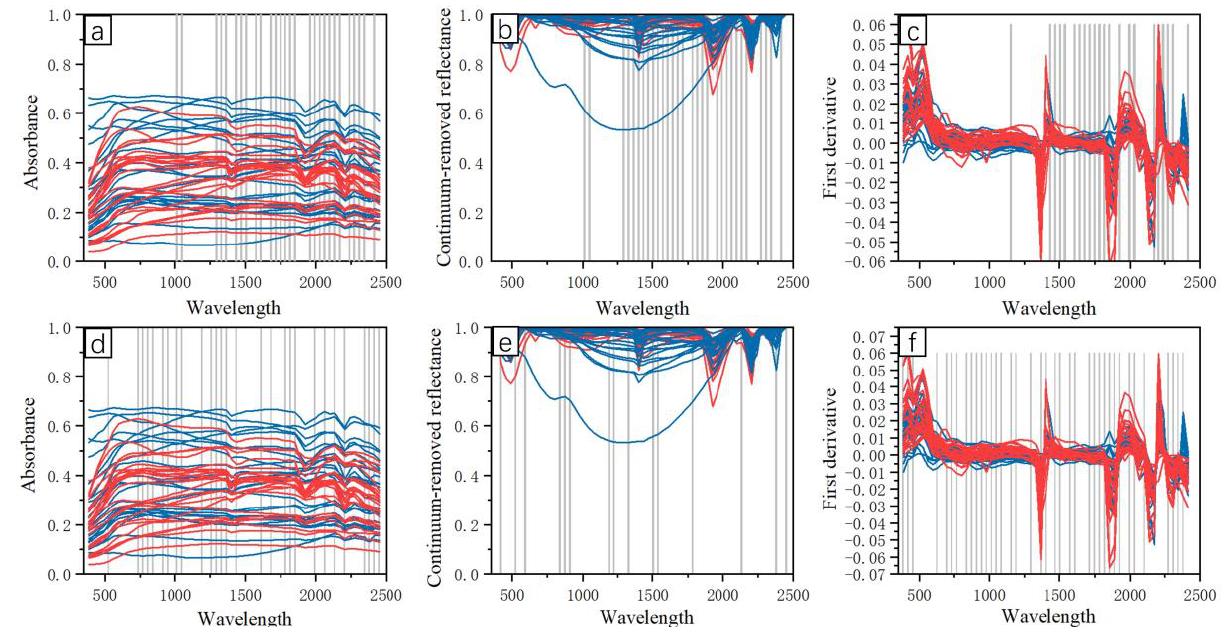
Figure 11. Automatic selection results of spectral features (red represents Li-rich pegmatite, blue represents Li-poor pegmatites, and the gray band indicates the selected band position). ( a ) Minimum angle regression feature selection of the original spectrum. ( b ) Minimum angle regression feature selection of continuum removal spectra. ( c ) Minimum angle regression feature selection of the first derivative. ( d ) Genetic algorithm feature selection of the original spectrum. ( e ) Genetic algorithm feature selection of the continuum removal spectra. ( f ) Genetic algorithm feature selection of the first derivative.